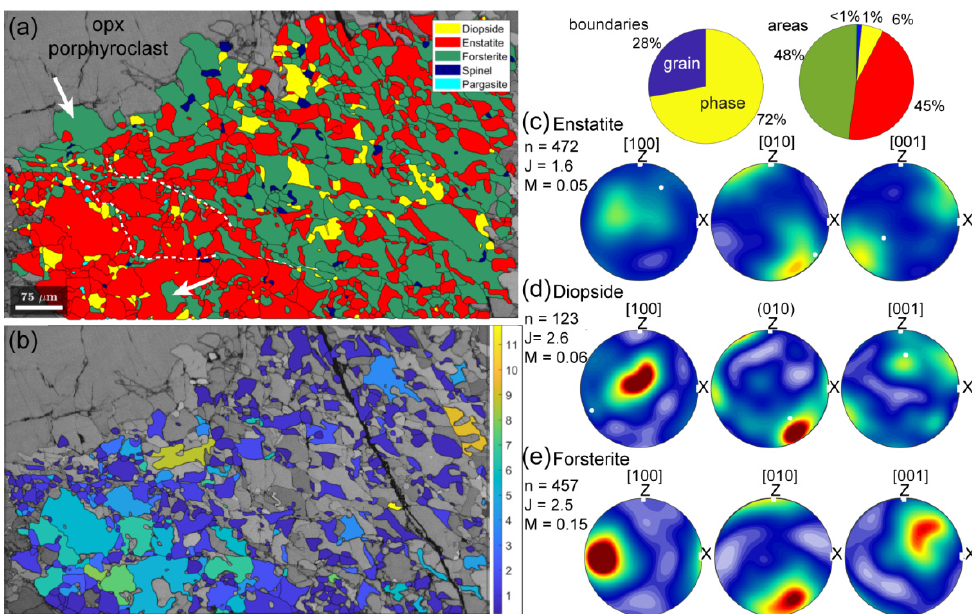
Figure 10. ( a ) Phase map of a recrystallization tail of an opx porphyroclast (ROI20), located at the top left of the map. The white arrows indicate an olivine embayments in the opx porphyroclast and an opx neoblast. The white dashed lines follow cracks along which small grains are visible. Shown at the top right are the grain and phase boundary percentages and area percentages. ( b ) Band contrast image and the grain orientation spread (GOS) in each enstatite grain. ( c – e ) CPO of enstatite, diopside and forsterite.